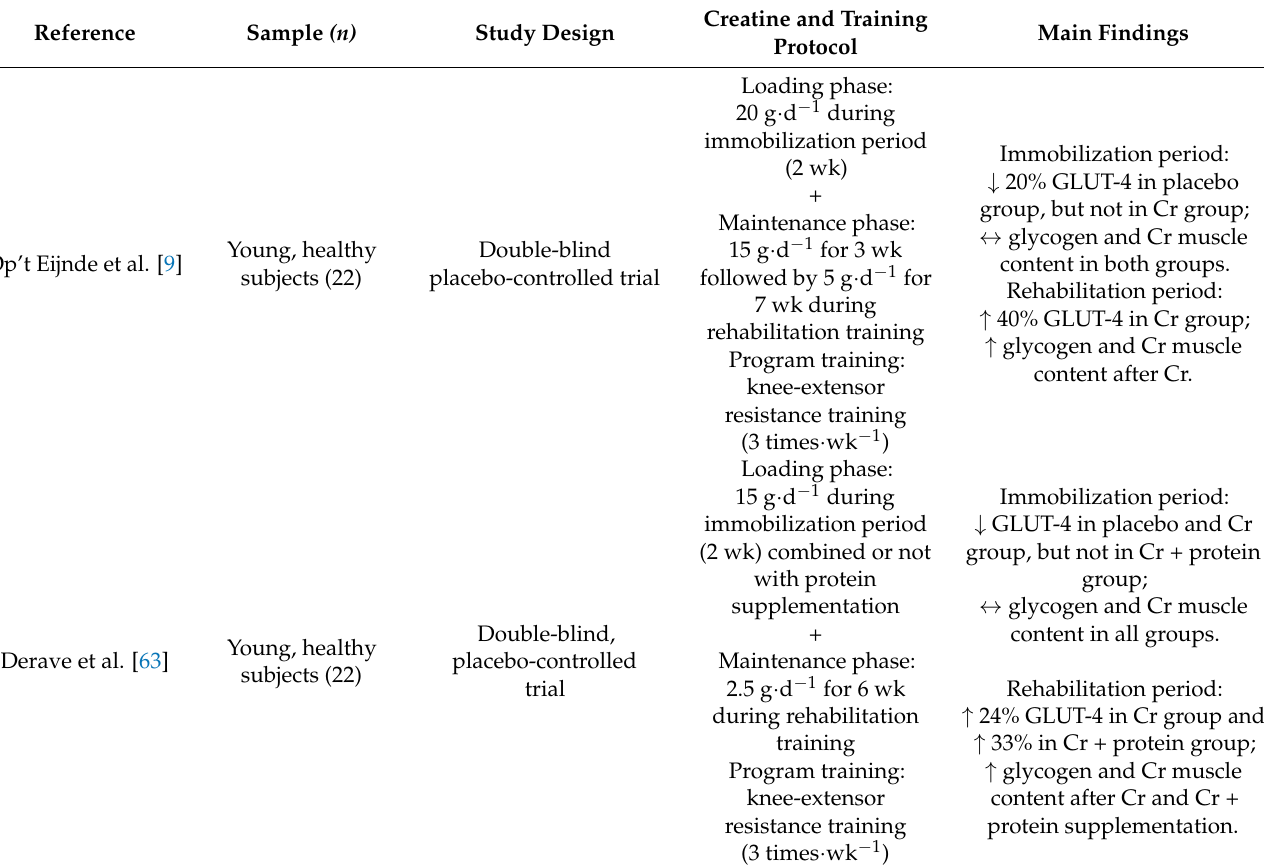
Table 4. Effect of creatine supplementation along with exercise on glucose metabolism in humans. Reference Study Design